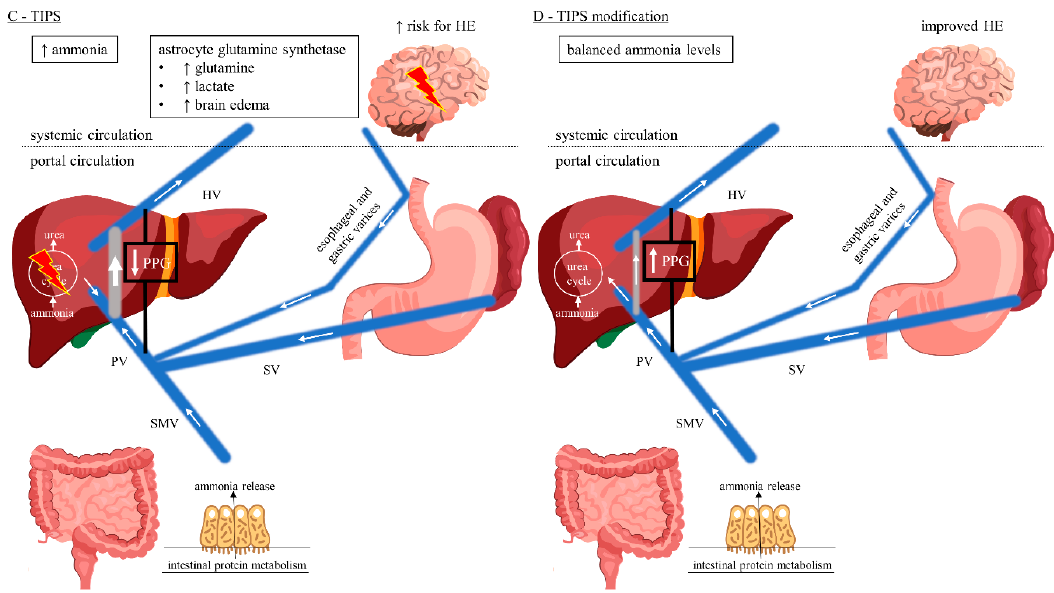
Figure 1. Gut–liver–brain pathway of HE considering porto-systemic hemodynamics. ( A ) Normal liver function with hepatopetal blood flow. Ammonia released from the gut enters the portal circulation and is detoxified in the liver via the urea cycle. Normal systemic ammonia levels, no HE being present. ( B ) Chronic liver disease with hepatofugal blood flow reversal resulting in development of porto-systemic collaterals and splanchnic blood shunting into the systemic circulation. Hepatic urea cycle is bypassed resulting in elevated systemic ammonia levels with increased risk for HE due to neuronal dysfunction. ( C ) TIPS with predominantly hepatopetal blood flow towards the low-pressure shunt rather than liver parenchyma, achieving decreased splanchnic blood shunting. Intrahepatic portal vein flow is hepatofugal and into the shunt. The hepatic urea cycle is again bypassed resulting in elevated systemic ammonia levels with increased risk for HE, in an acute setting, due to the increased metabolism of ammonia to glutamine by the astrocytes, with a subsequent tendency to edema. ( D ) Endovascular shunt modification decreases the shunt flow achieving hepatopetal flow reversal in the portal vein. Ammonia detoxification in the liver via the urea cycle is increased, thereby improving HE. This cover was created with resources from Freepik.com. Abbreviations: HE, hepatic encephalopathy; HV, hepatic vein; PPG, portosystemic pressure gradient; PV, portal vein; SMV,